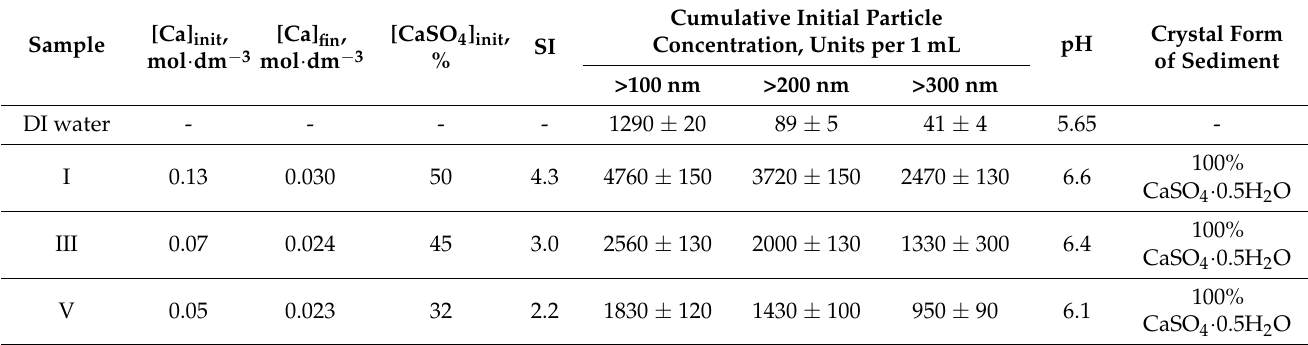
Table 1. Characteristics of the Blank experiments I, III and